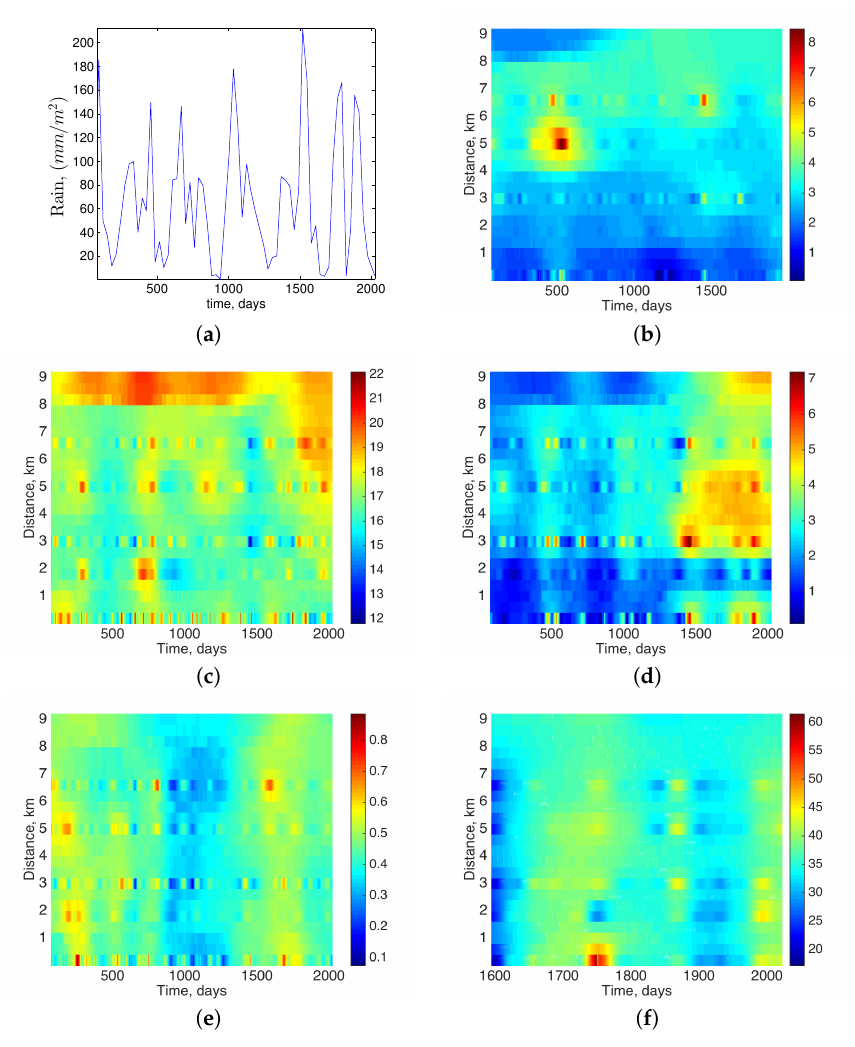
Figure 6. Spatio-temporal variation: ( a ) rainfall level in Quito from 2002 to 2007 at ‘La Tola’ monitoring station; ( b ) Q; ( c ) DO; ( d ) T; ( e ) BOD/COD; ( f )